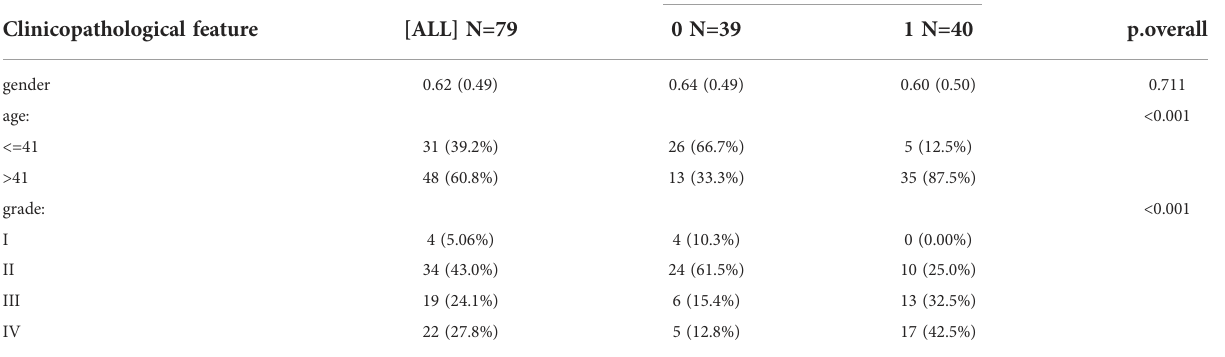
TABLE 1 Tissue microarray clinical